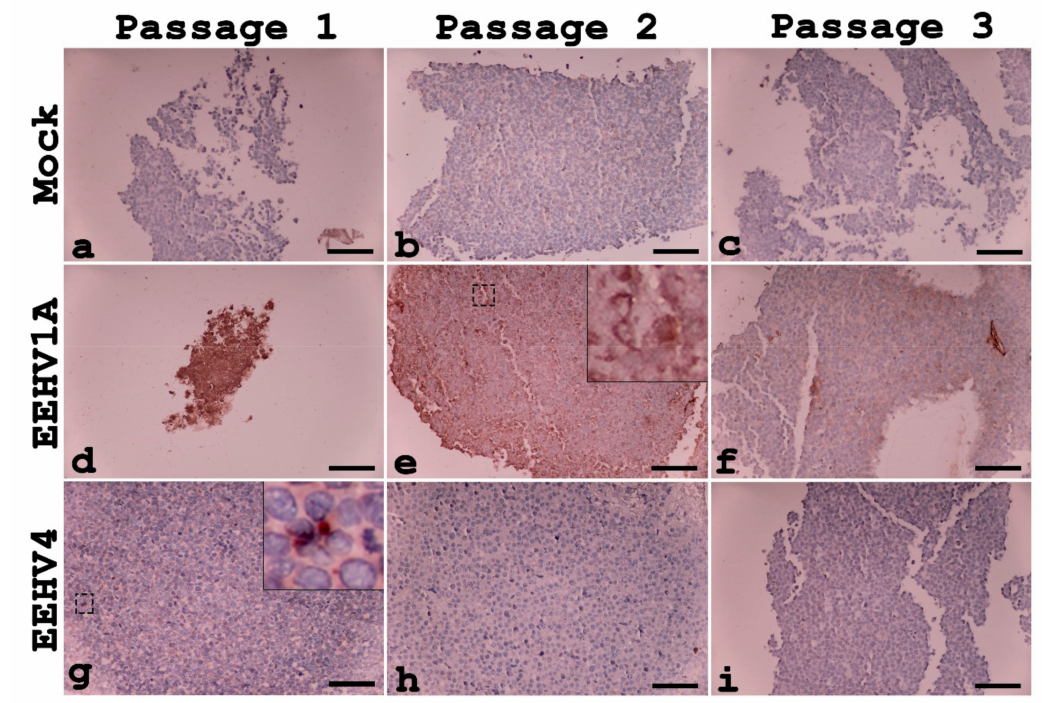
Figure 3. Representative photomicrographs of U937 cell pellets inoculated with supernatant obtained from passages 1, 2 and 3 of the EEHV-inoculated U937 cells. Immunolabeling for EEHV DNA polymerase antibodies was found to be strongly positive in the cytoplasm (inset) of the EEHV1A-inoculated ( d – f ) and EEHV4-inoculated ( g – i ) cells when compared to the mock-infected controls ( a – c ). However, immunolabeling in the positive cells for EEHV DNAPol declined in passages 3 and 2 of the EEHV1A- and EEHV4-inoculated groups, respectively. Scale bars ~800 µ